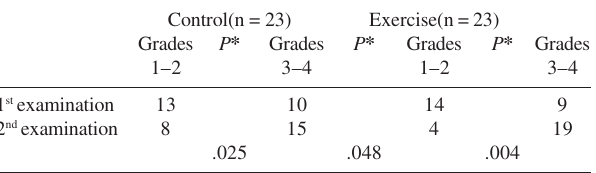
Table 3 - Distribution of the 46 patients studied (control and exercise groups) regarding the results of functional evaluation of the pelvic floor (FEPF) at the 1st (20 weeks of gestation) and 2nd examination (36 weeks of gestation) (HCFMUSP, November 2003 to December